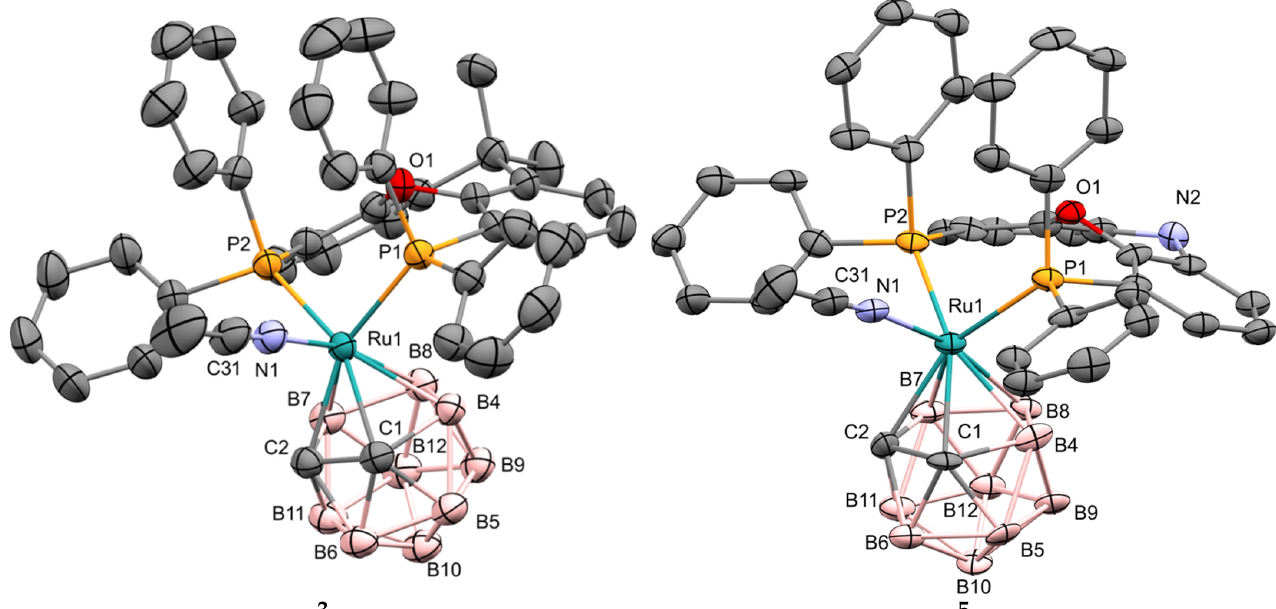
Figure 2. Molecular structures of ruthenacarboranes 3 and 5 (thermal ellipsoids drawn at the 50% probability level). Hydrogen atoms have been omitted for clarity.